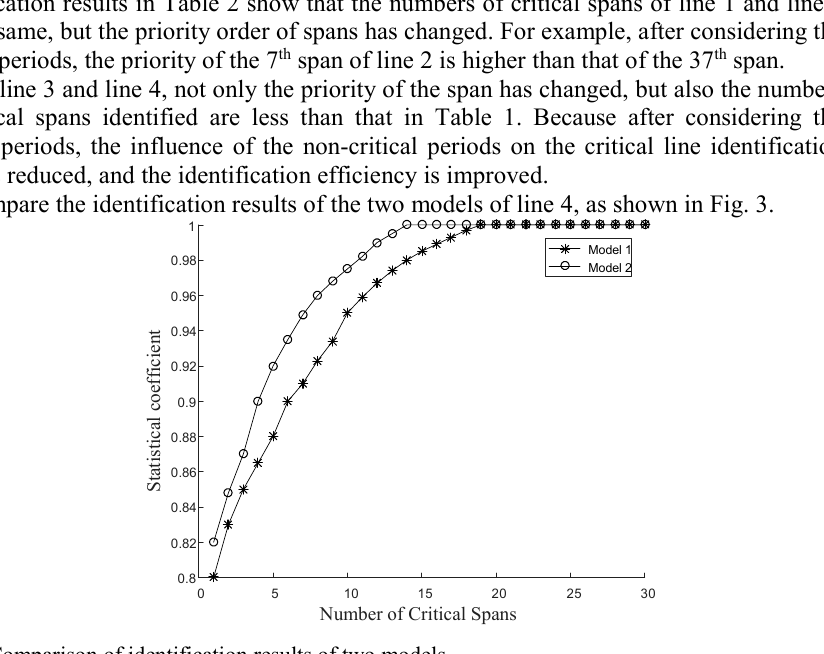
Fig. 3. Comparison of identification results of two